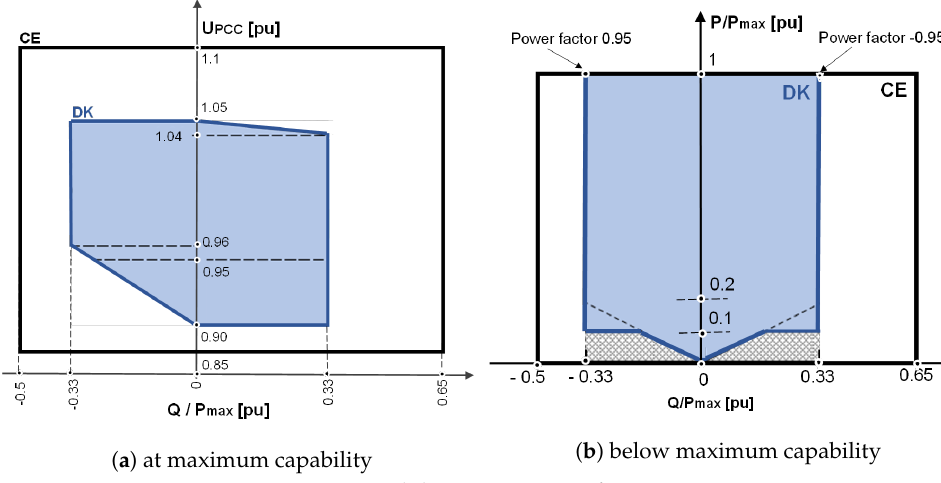
Figure 5. Reactive power provision capability requirements for power generating units in Denmark (DK) is within the recommended envelope by EU CR for Continental Europe